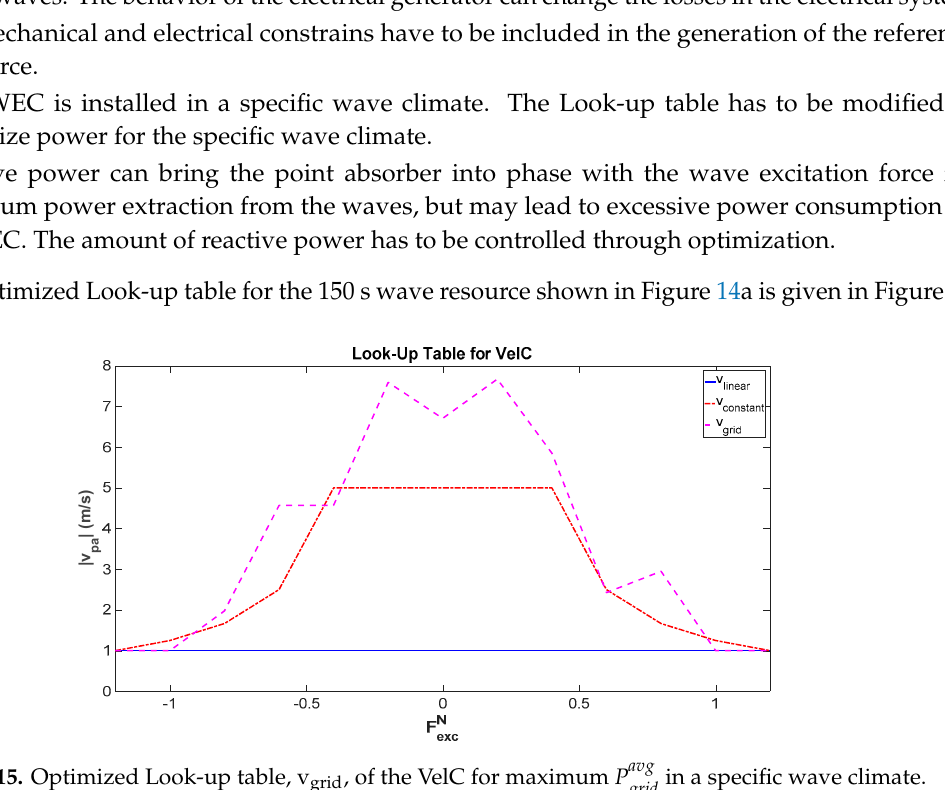
in a specific wave climate. grid